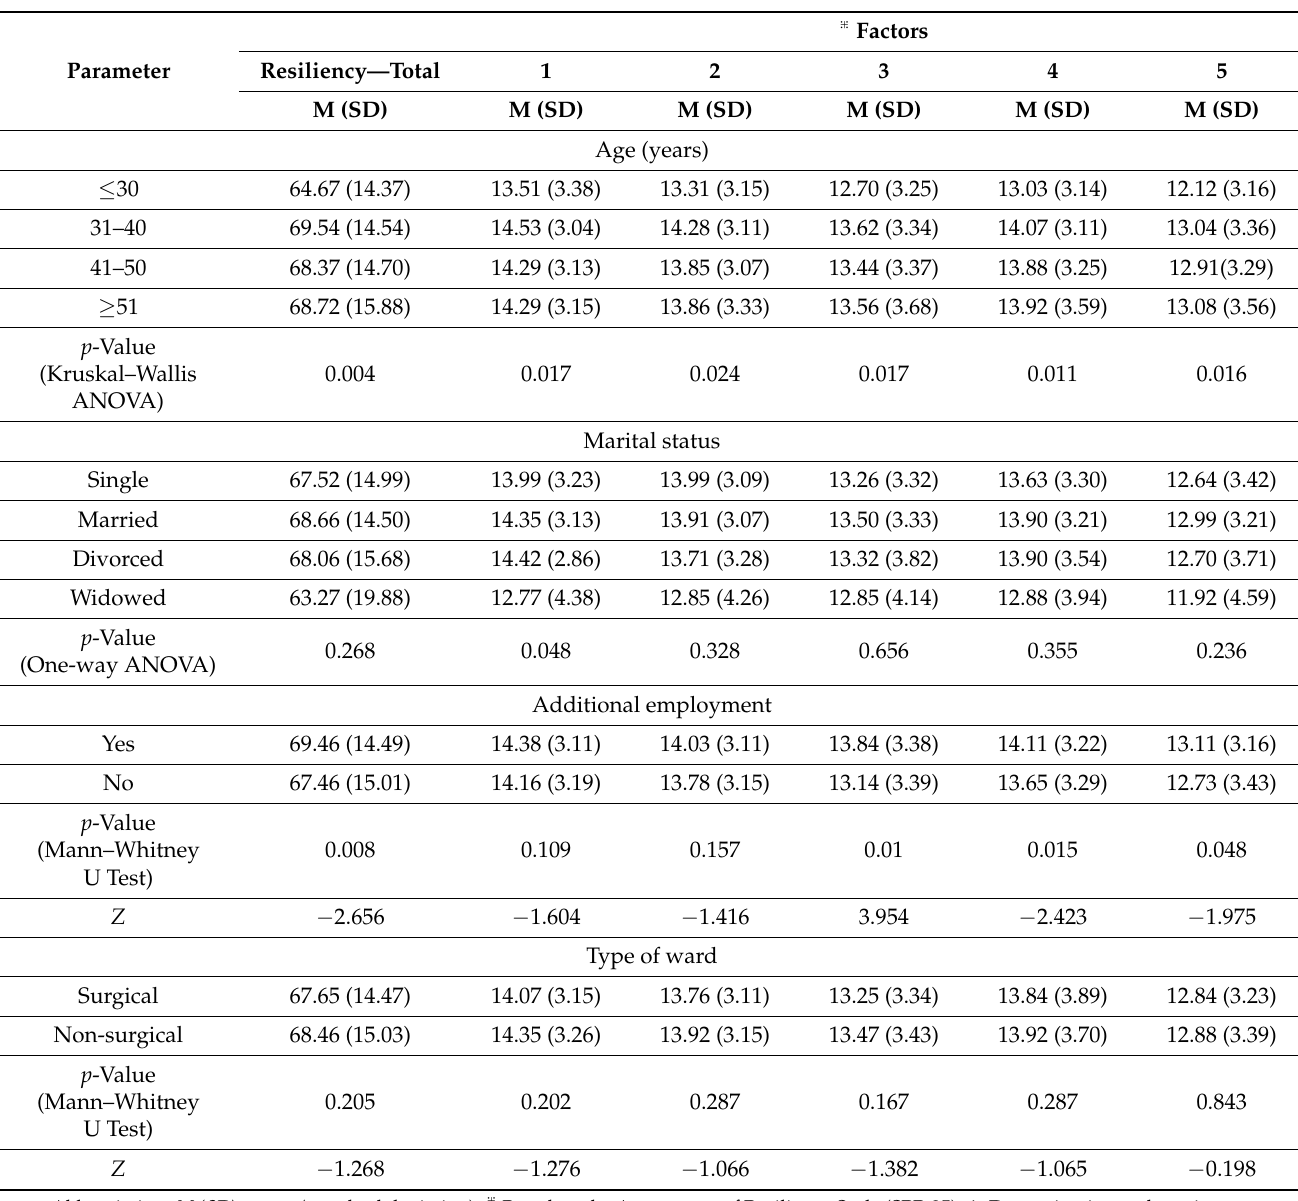
Table 4. Relationships between resilience and the sociodemographic characteristics of Polish nurses. Table 1. General characteristics of the analysed group of nurses in Poland.